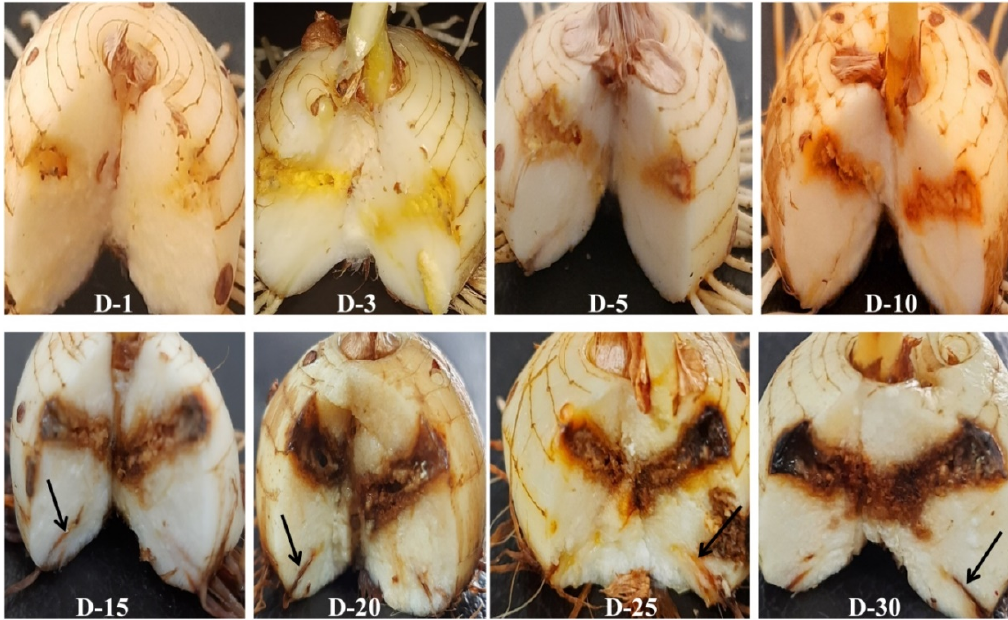
Figure 4. Symptoms of corm rot caused by Fox R1 infection in the dissected corms of T3 (corm injury + Fox R1) treatment. D1–D30 represents days post-inoculation. Arrows indicate the growth of Fox R1 in the root primordia.